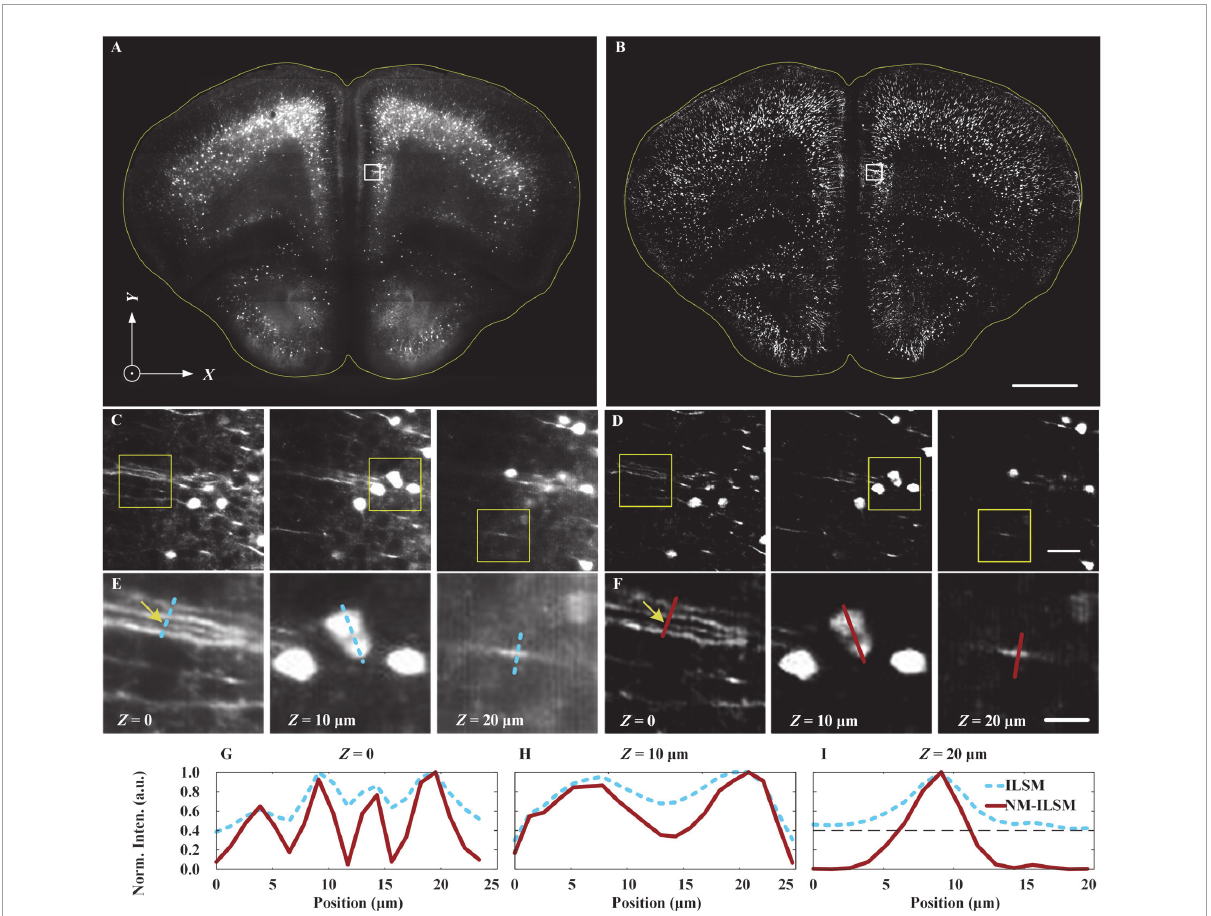
FIGURE5 Inverted light-sheet microscopy and NM-ILSM image quality comparison. ILSM (A) and NM-ILSM (B) MIP images for a 20- µ m-thick coronal slice of a Thy1-GFP mouse brain. Scale bar: 1 mm. (C,D) Expanded views at depths of Z = 0, 10, and 20 µ m (left to right) of the areas outlined by white boxes in (A,B) , respectively. Scale bar: 50 µ m. (E,F) Expanded views of the areas outlined by the yellow boxes in (C,D) , respectively. Scale bar: 20 µ m. (G–I) Normalized intensity profiles along the correspondingly colored lines in (E,F)